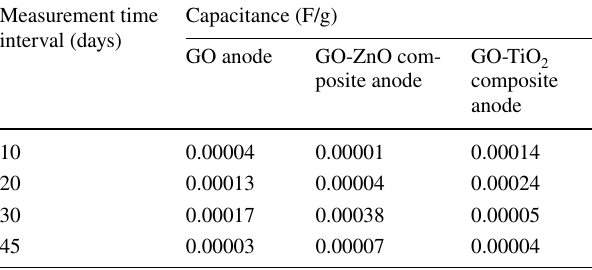
Table 2 Cs assessments at different time interval during the operation Measurement time interval